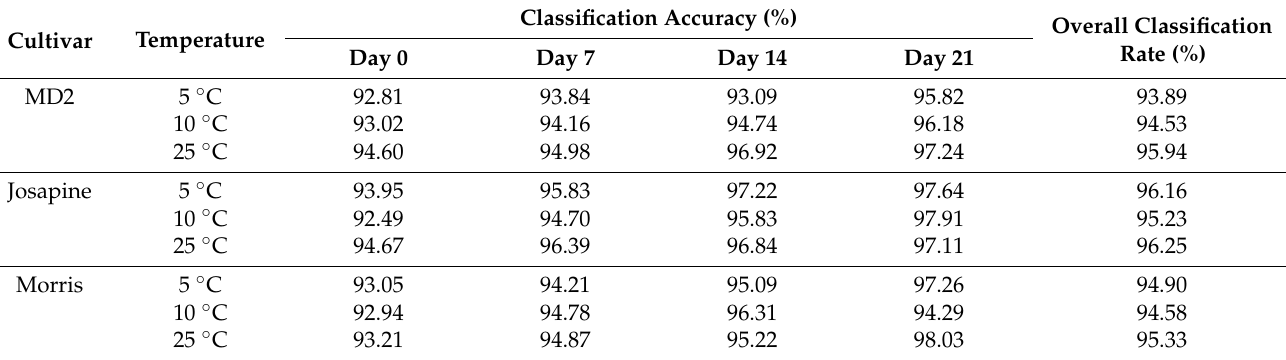
Table 2. Classification performance of pineapple cultivars at different storage days and temperatures using linear discriminant